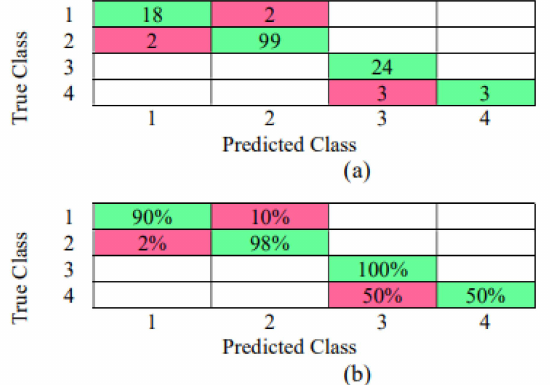
Figure 7. Confusion matrix of linear SVM that was applied to the standardization data (Green refers to True Positive, red refers to False negative) ( a ) corrected prediction samples for each class ( b ) prediction accuracy of each